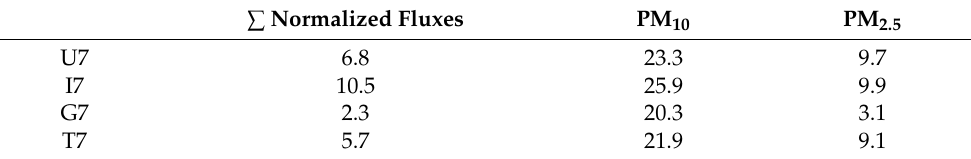
Table 2. Summation of normalized fluxes, PM 10 and PM 2.5 average concentrations ( µ g m − 3 ). ∑ Normalized